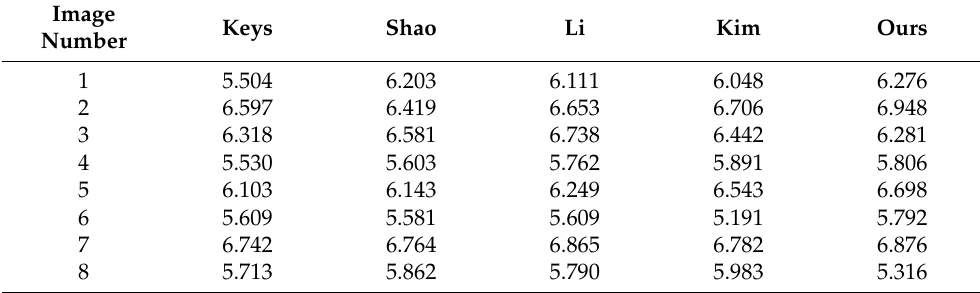
Table 2. Comparison of IE indexes of images reconstructed using different methods.